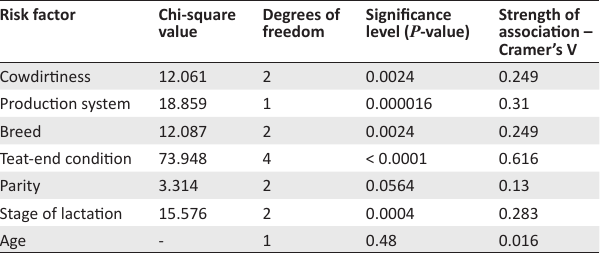
TABLE 5: Percentage mastitis prevalence in different production systems.